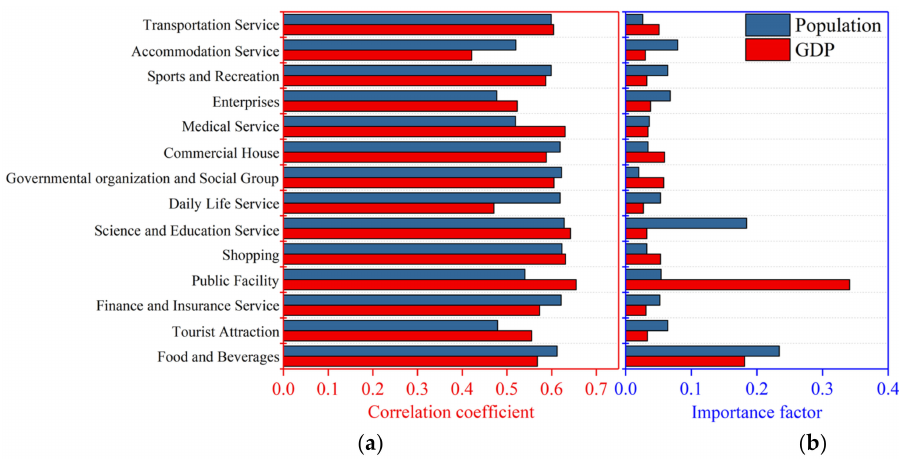
Figure 10. Correlation and importance of different categories of POIs kernel densities with GDP and population. ( a ) Correlation coefficient; ( b ) importance